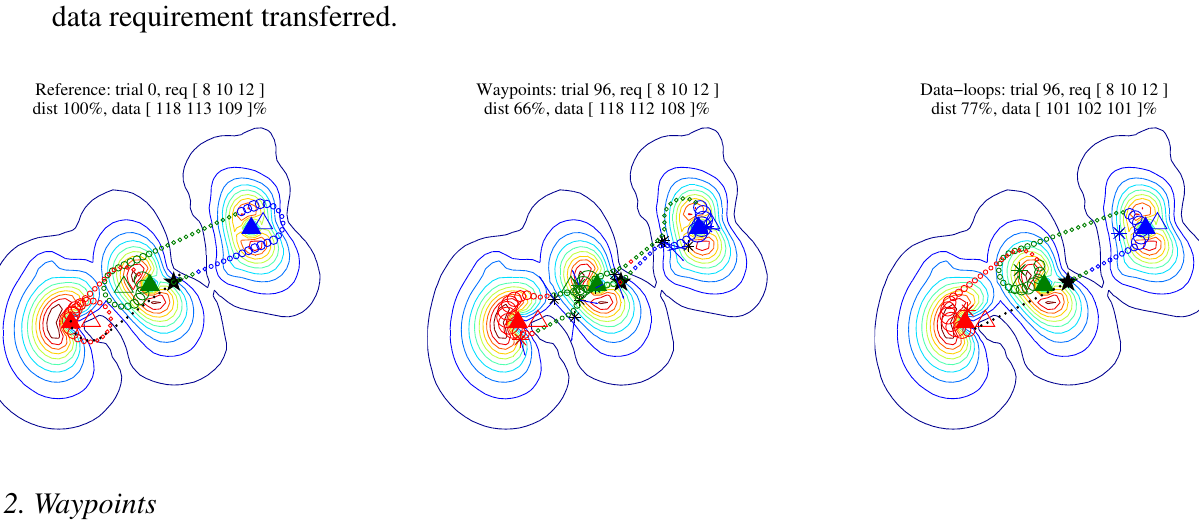
Figure 1. Sample trajectories plotted in space, superimposed over reference rate contours that show what the aircraft would see in flat level flight (not what it actually sees as it steers and banks). Six noise transmitters, of the same signal strength as the sensors, sit at unknown locations. The aircraft starts at ⋆ and passes each waypoint (*) as described in Section 4 (node-locked waypoints are shown in the colour of their designated nodes). Actual node locations are at ▲ ; their assumed positions are at △ (drawn from a Gaussian about the true positions, σ = 3 . Left: Reference. Middle: Waypoints planner with 3 waypoints per node. Right: Data-loops planner with 1 waypoint locked to each node. Circle size is proportional to data rate. “req” is the data requirement per node (blue, green, red), “dist” is the distance travelled compared to the Reference trajectory, and “data %” shows the proportion of the data requirement